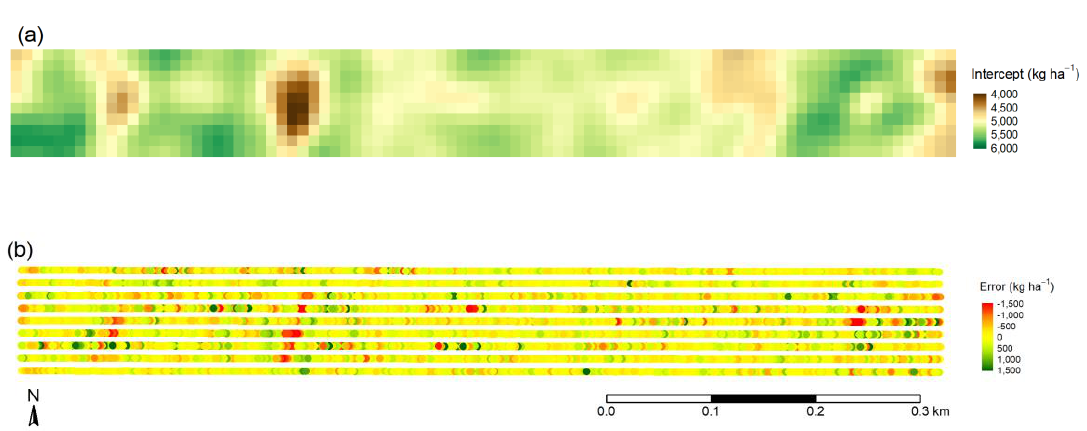
Figure 10. ( a ) Yield intercept (kg ha − 1 ) from geographically weighted regression (GWR) applied to the Cunderdin trial and ( b ) model error for the Cunderdin trial.